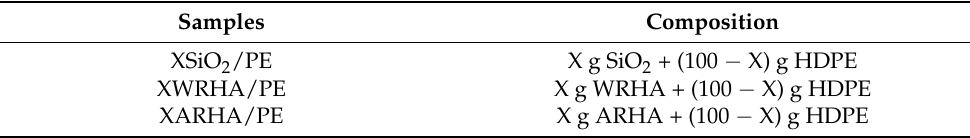
Table 2. Composition and names for HDPE